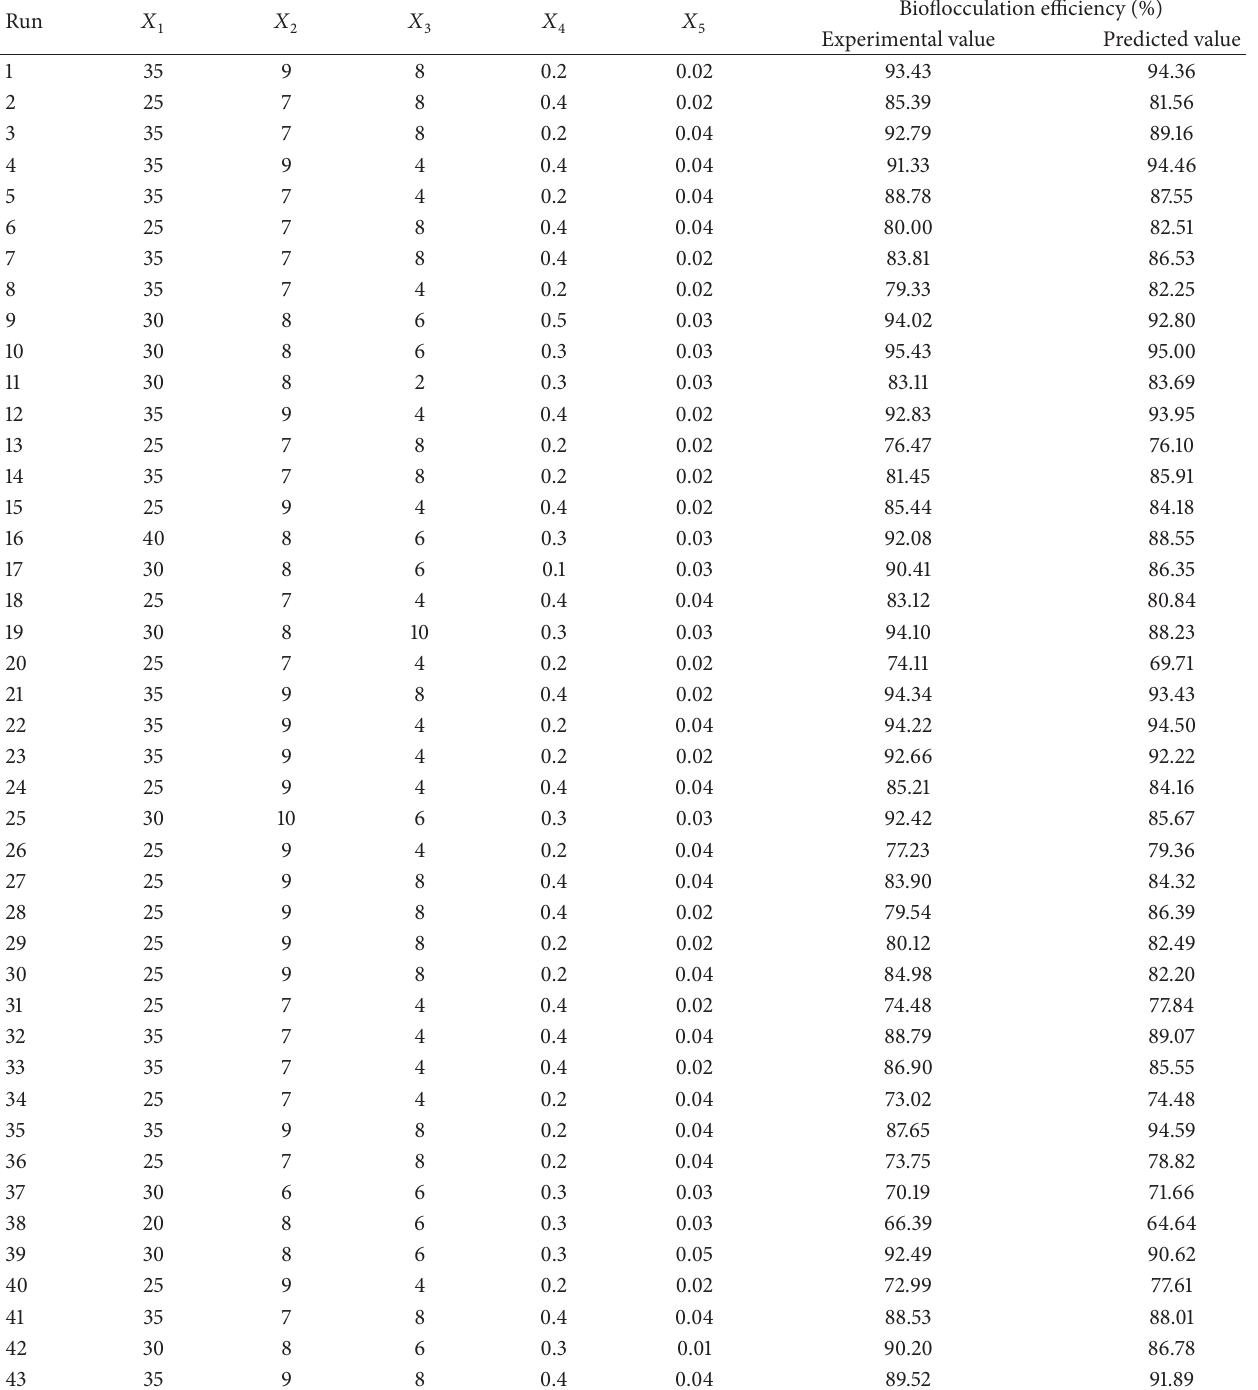
Table 2: Central composite design matrix of orthogonal values with observed responses on bioflocculation